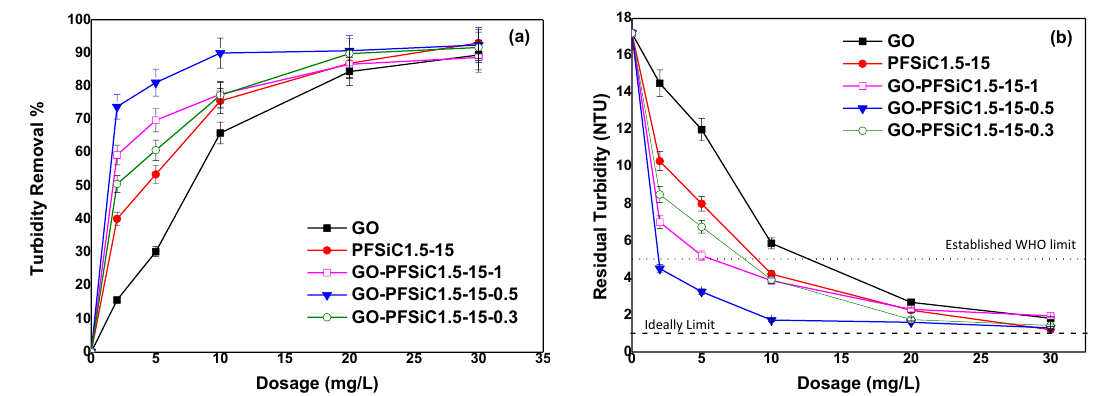
Figure 5. Determination of the optimum dosage and best material type, by comparing GO, PFSiC 1.5-15 , GO- PFSiC 1.5-15-1 , GO- PFSiC 1.5-15-0.5 , and GO- PFSiC 1.5-15-0.3 materials, regarding the removal of turbidity, treating simulated surface water samples, expressed ( a ) as % removal, and ( b ) as residual turbidity